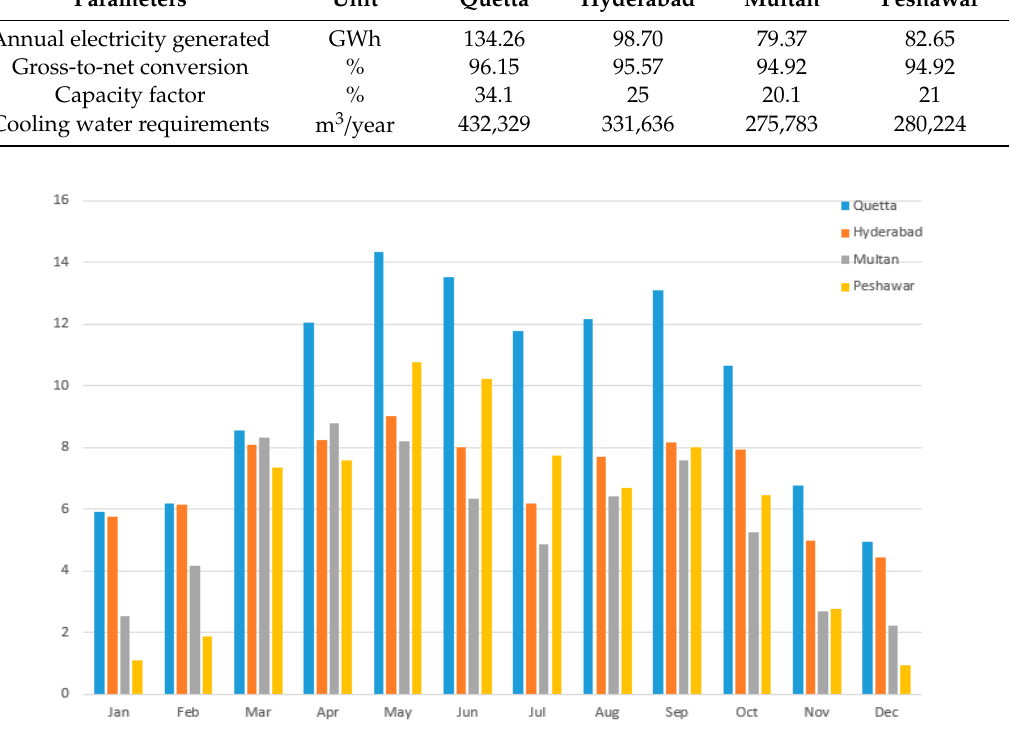
Figure 19. Electricity production by the 50 MWe LFR plant with dry cooling for different regions. Table 12. Performance parameters of the 50 MWe LFR plant with air cooling.